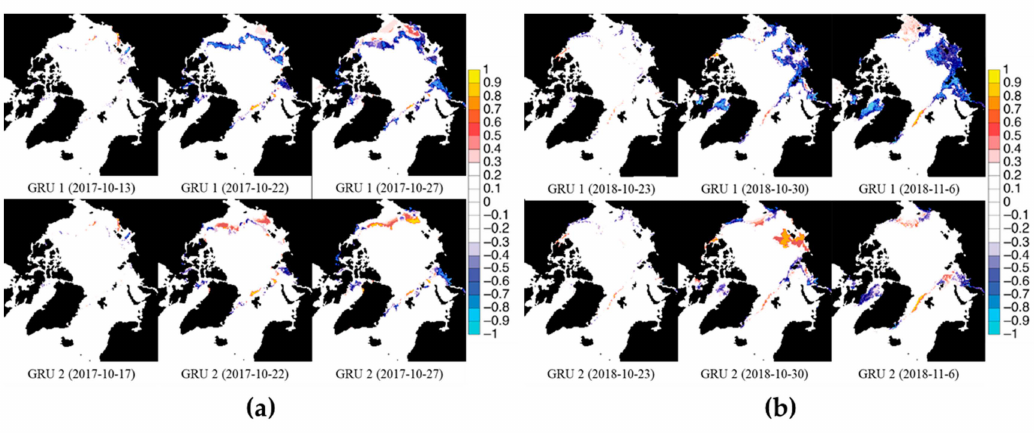
Figure 11. SIC deviation: ( a ) Period 20; ( b ) Period